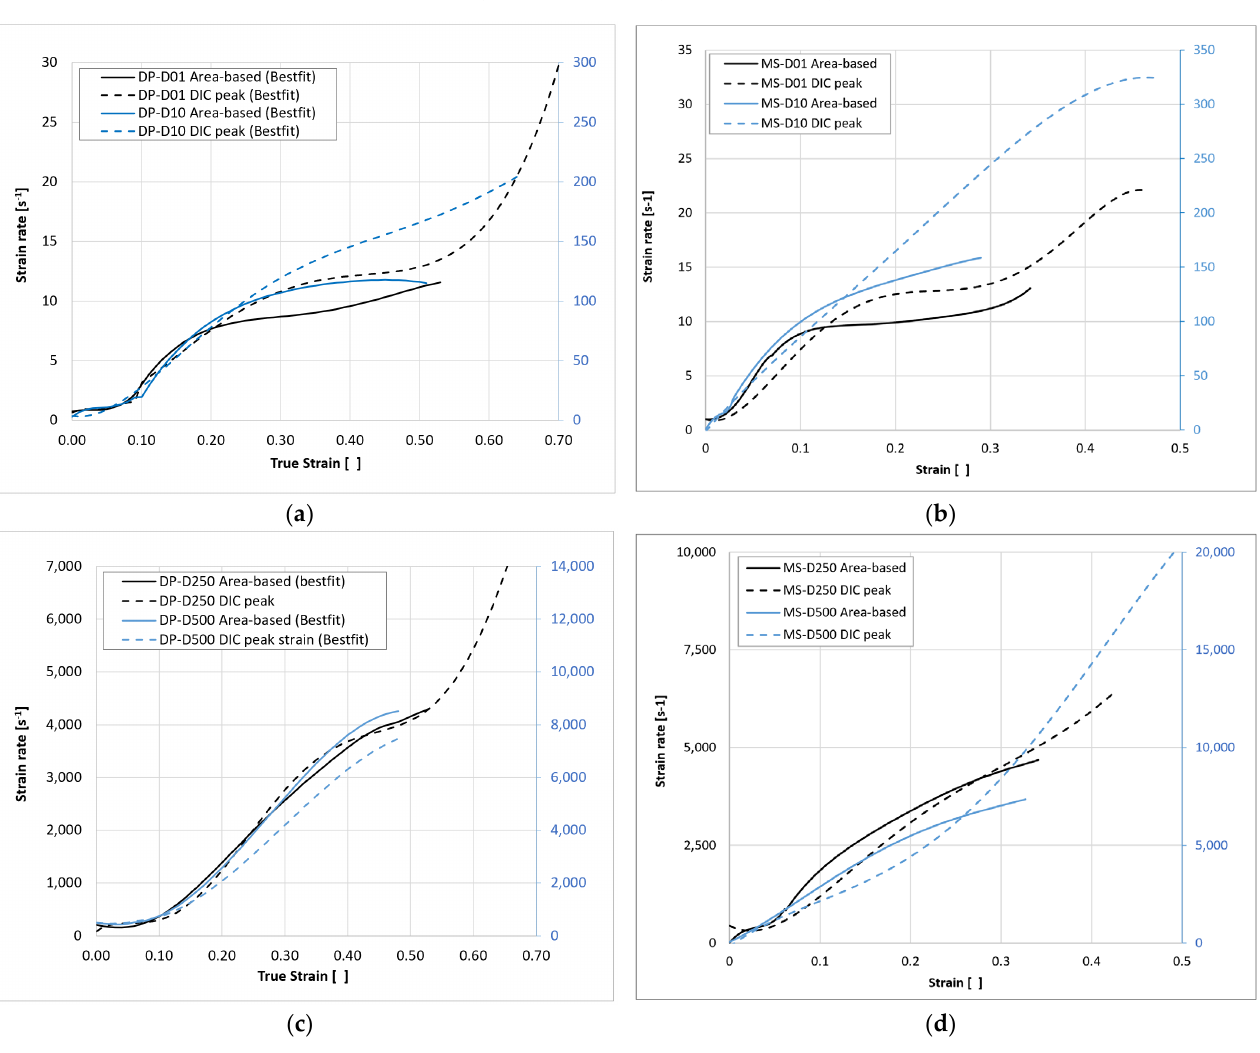
Figure 19. Specimen profile imperfections in the DP1000 ( a ) and the MS1700 ( b ) steels due to waterjet cutting.